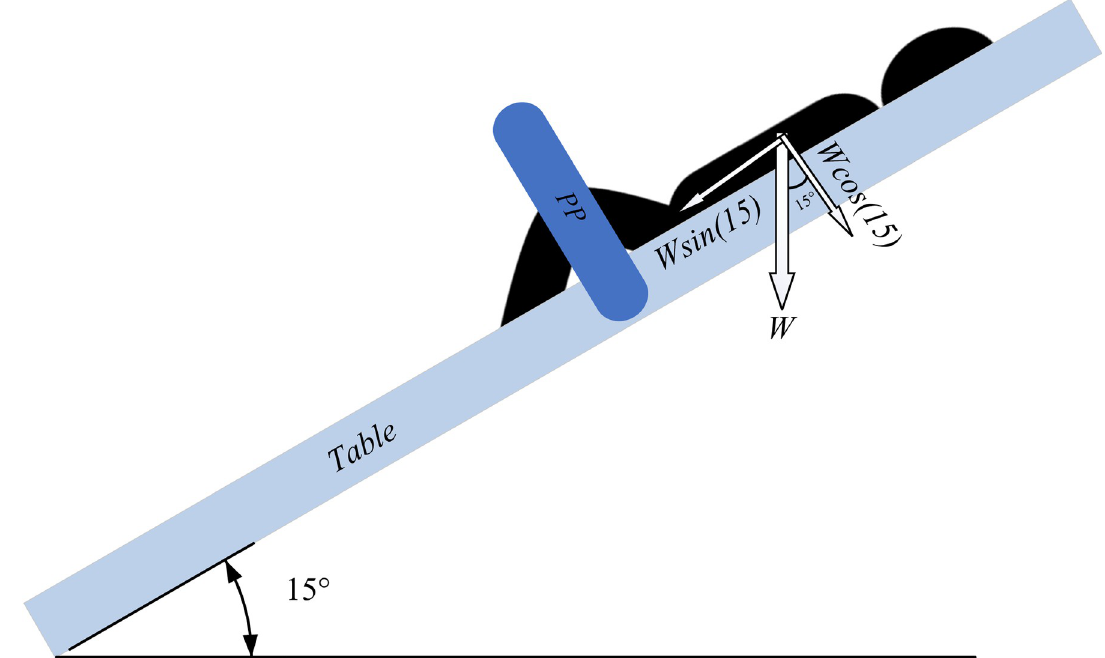
Fig 36. Simple diagram illustrating the applied force on PP in worst case scenario.